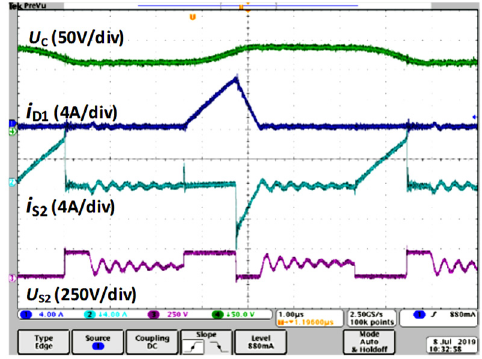
Figure 16. Steady-state operation of SCVD in DCM. Waveforms of voltage on switched capacitor C , current of D 1, current of transistor S 2, voltage on transistor S 2. U in = 200 V, f S = 134.4 kHz, D = T 1 / T S = 15.6 %, t M = 50 ns. Switching pattern P3.